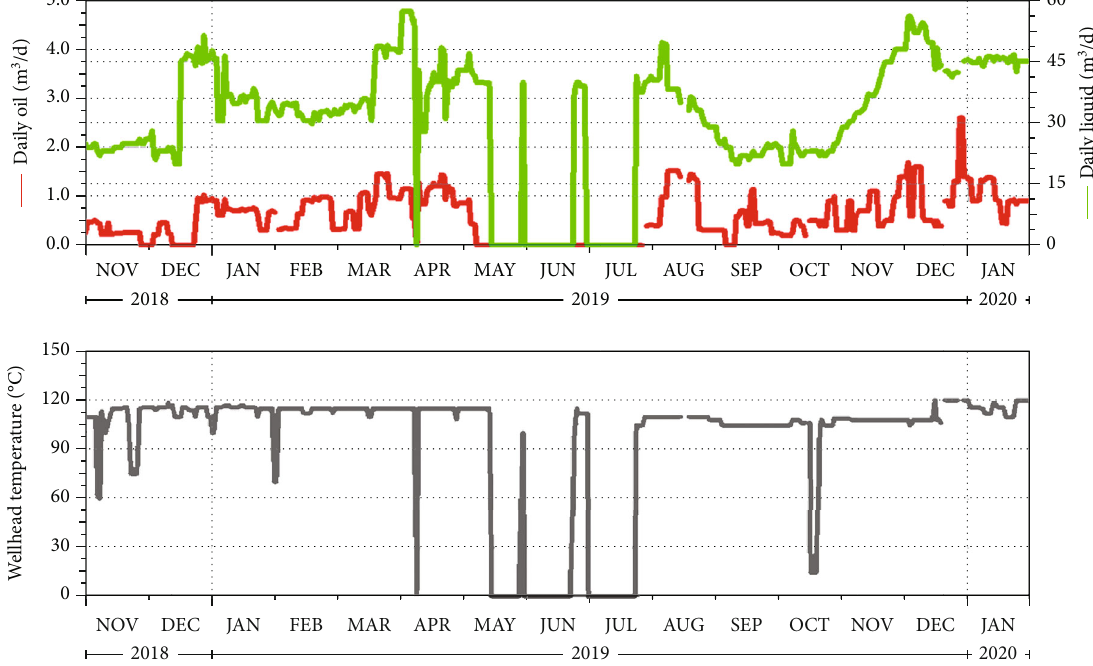
Figure 12: Typical production curves for a type I well.